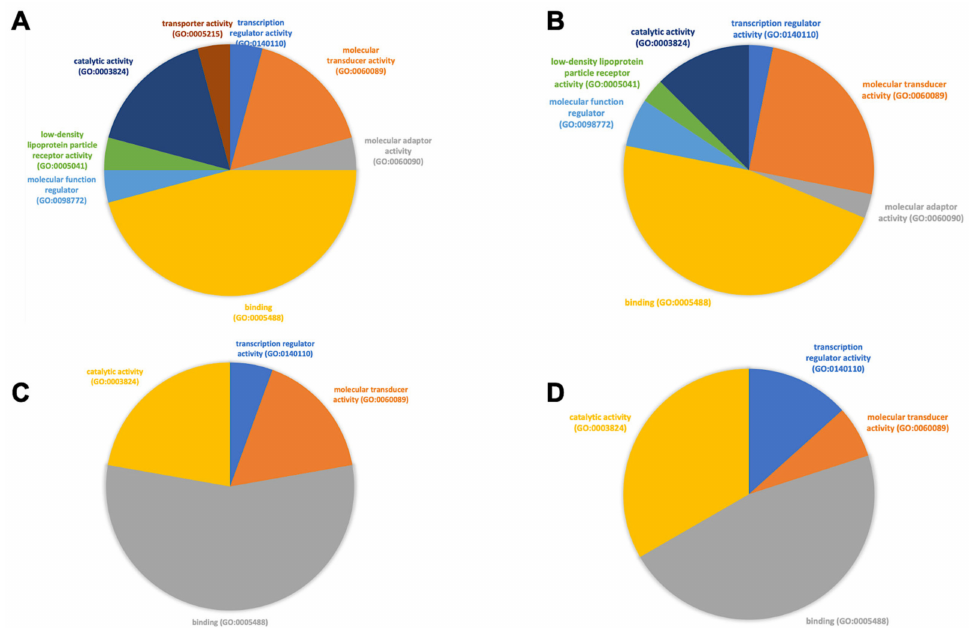
Figure 6. Molecular function of the most commonly expressed genes in different cell subtypes across patients. Individually, the unique, most commonly expressed genes in COVID-19 and bacterial sepsis patients with mild and severe disease manifestations, found in Supplementary Material S2, were submitted to the PANTHER software. A molecular function involvement analysis of the genes was returned by the software and was later coded into pie charts. Less molecular functions were performed by the genes involved in the sepsis cohort ( C ), i.e., catalytic activity, transcription regulator activity, molecular transducer activity, and binding. The catalytic activity and binding functions were more abundant in patients with severe sepsis (i.e., septic shock, D ), while the remaining functions were higher in patients with non-severe sepsis. There was a higher enrichment of functions associated with the genes in the COVID-19 patients ( A , B